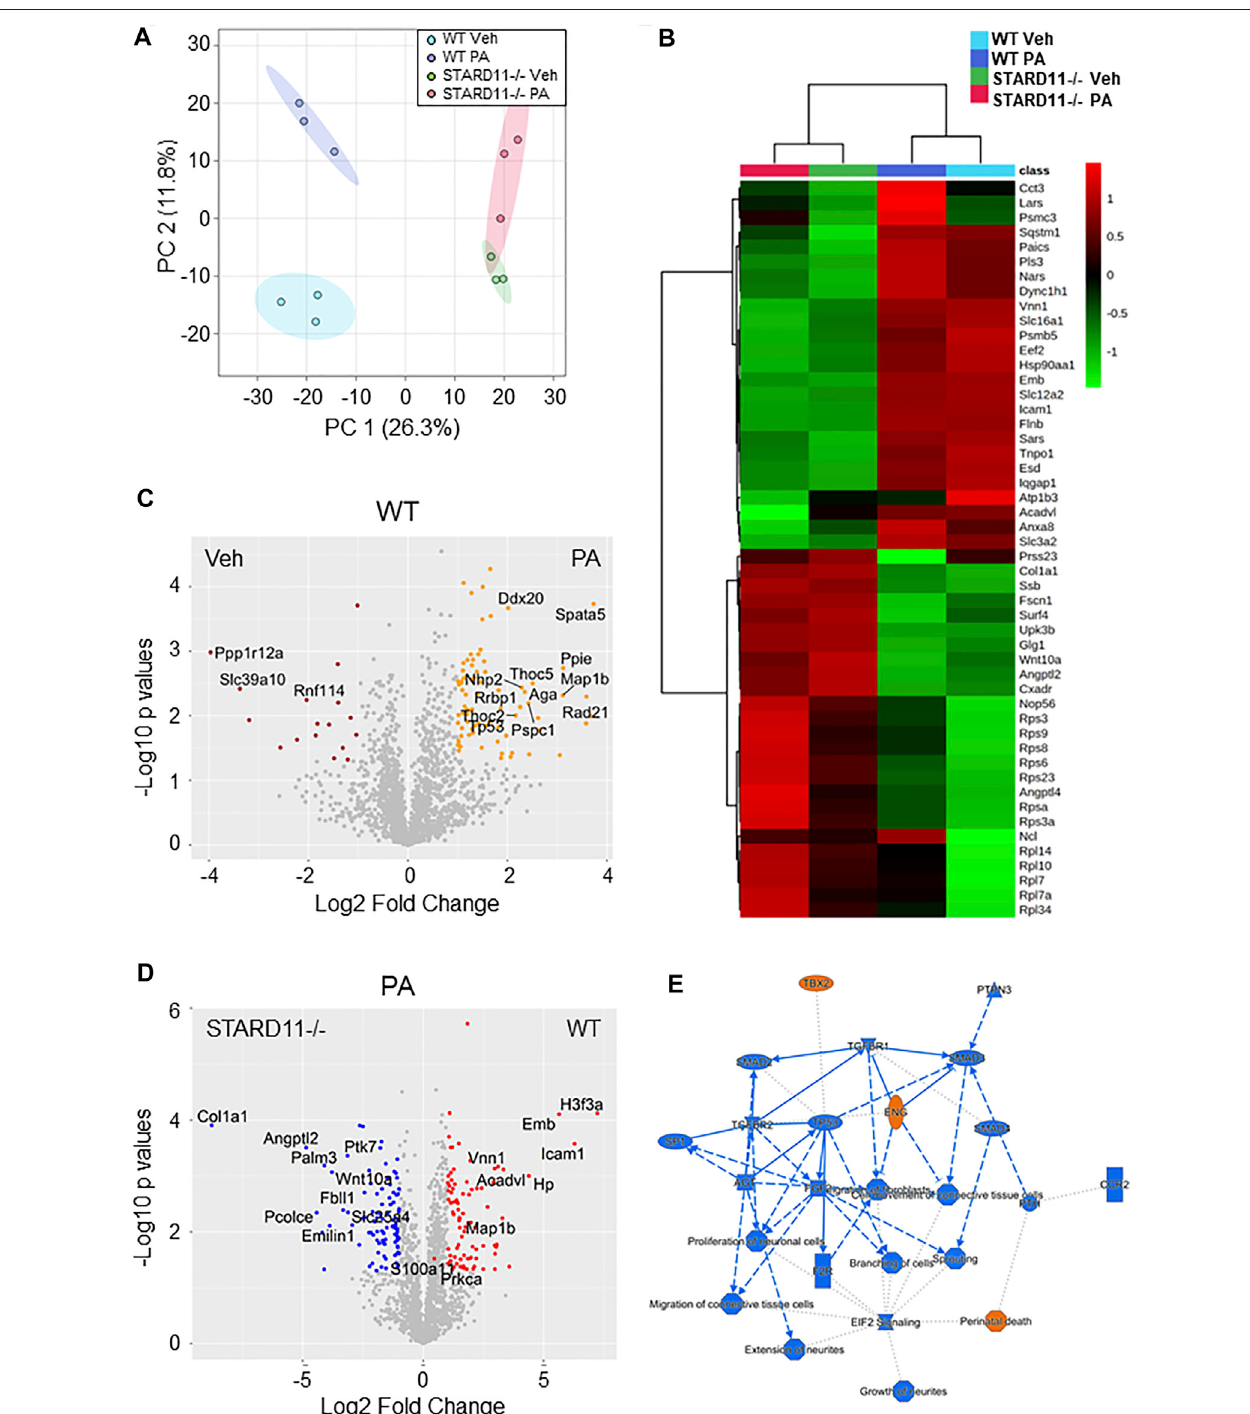
FIGURE 3 | Comparative proteomics of lipotoxic EVs from WT or STARD11-/- cells. (A) Principal component analysis of proteins detected in wild-type (WT) or STARD11 knockout (STARD11-/-) extracellular vesicles (EVs) from palmitate (PA)- or vehicle (Veh)-treated cells. (B) The heatmap depicts top 50 signi fi cant proteins betweenfourdifferentgroups. (C) VolcanoplotshowscomparisonbetweenWTVehandWTPA;orangecirclerepresents p < 0.05andLog2Foldchange > 1;redcircle represents p < 0.05 and Log2 Fold change < − 1. (D) Volcano plot shows comparison between STARD11-/- PA and WT PA; red circle represents p < 0.05 and Log2 Fold change > 1; blue circle represents p < 0.05 and Log2 fold change < − 1. (E) Figure shows ingenuity pathway analysis based on WT PA/STARD11-/- PA data.